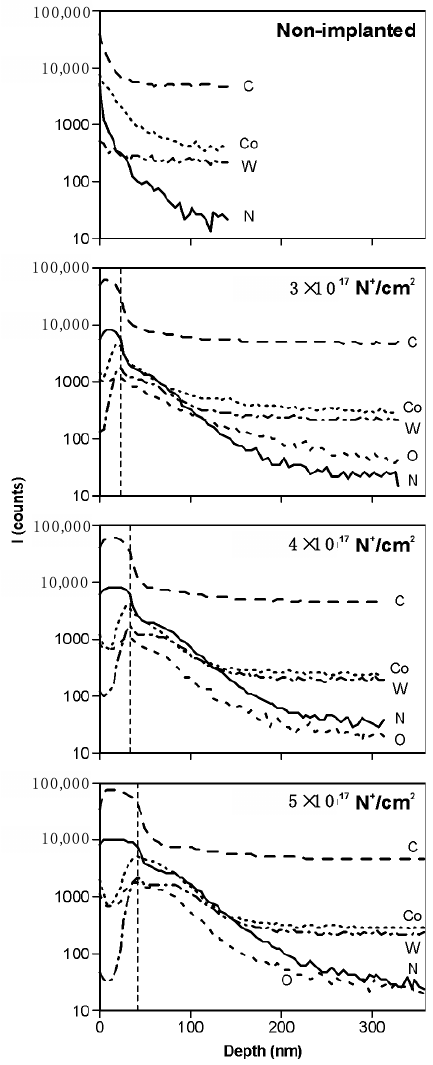
Figure 6. Secondary Ion Mass Spectrometry (SIMS) depth profile analyses of the nonimplanted sample and samples implanted with nitrogen.